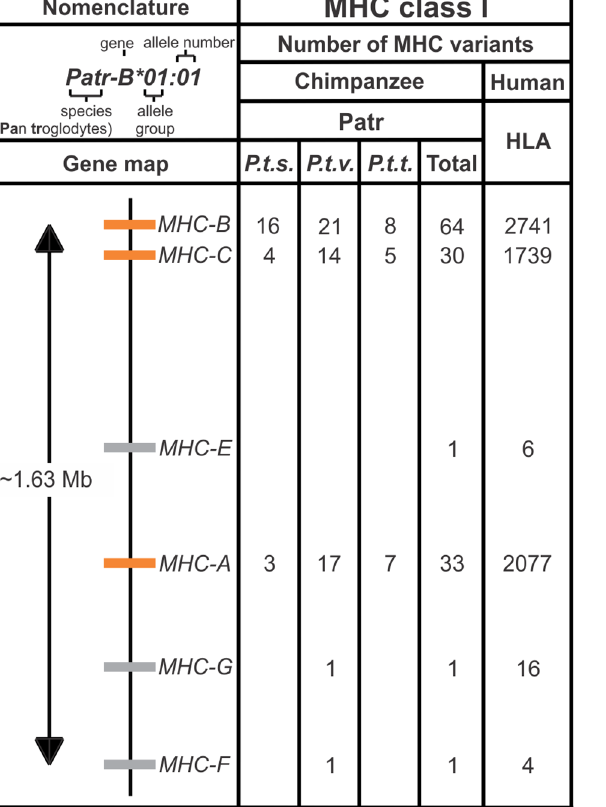
Fig 1. Organization and polymorphism of human and chimpanzee major histocompatibility complex (MHC) class I genes. Humans and chimpanzees have six orthologous MHC class I genes: MHC-A, -B, -C, -E, -F, and -G . Human genes and alleles have the prefix HLA- (Human Leukocyte Antigen). Chimpanzee genes and alleles have the prefix Patr- ( Pan troglodytes ). The gene map shows their relative organization within the MHC. Each gene encodes a cell-surface glycoprotein that is involved in activating cytotoxic T and NK cell responses against infection. MHC-A, -B, and - C (orange) are highly polymorphic; MHC-E, F, and G (gray) are conserved. Under “ MHC class I ” are given the number of protein variants (allotypes) so far defined for each gene. For chimpanzees, these numbers are given for the three subspecies studied: P. t. schweinfurthii (P.t.s.) (the number given includes the novel Patr-B alleles defined in this study), P. t. verus (P.t.v.) , and P. t. troglodytes (P.t.t.) . For the subspecies P. t. ellioti , MHC class I genes have yet to be studied. The sum of all chimpanzee allotypes identified is given under “ Total. ” The subspecies origin of the Patr-E variant sequenced is not known. Under “ Nomenclature ” is shown the standardized nomenclature for Patr-B alleles, the subject of this paper. Further information is given on the http://www.ebi.ac.uk/ipd/imgt/hla/ and http://www.ebi.ac.uk/ipd/mhc/ websites